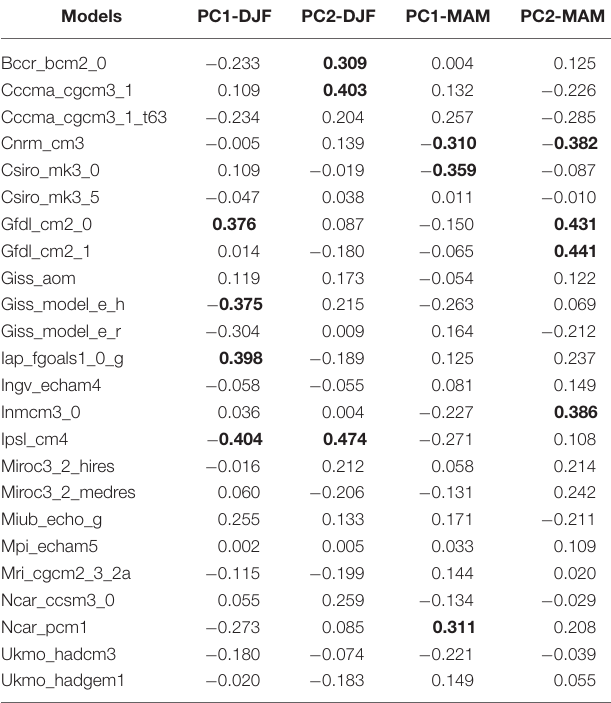
PC means time variation of the Principal Components and indicates how the EOFs change in time. Bolded numbers indicate statistical significance of the correlation at 95% according to the Student’s